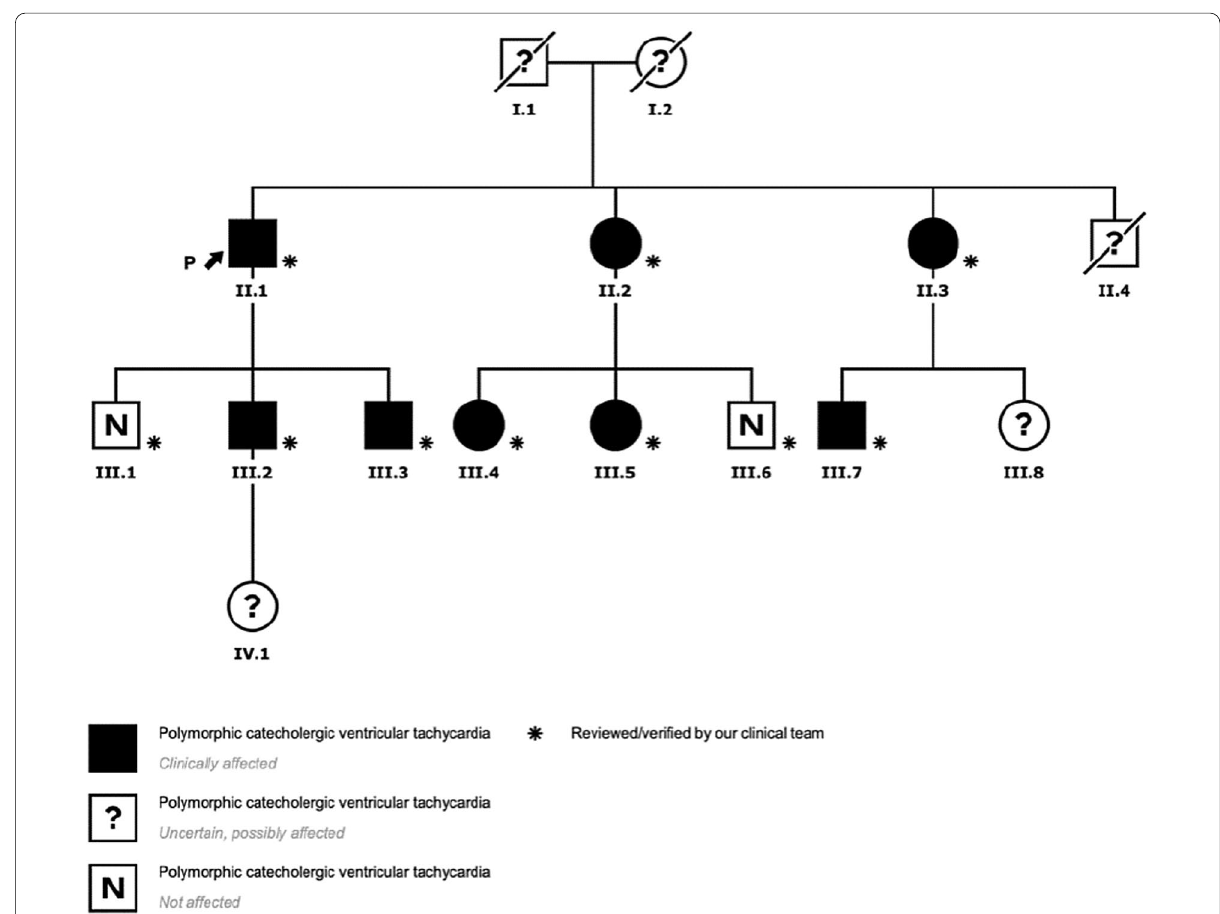
Fig. 2 Genealogical tree of the family. The arrow indicates the proband, and the asterisks denote the patients who have been evaluated by our medical